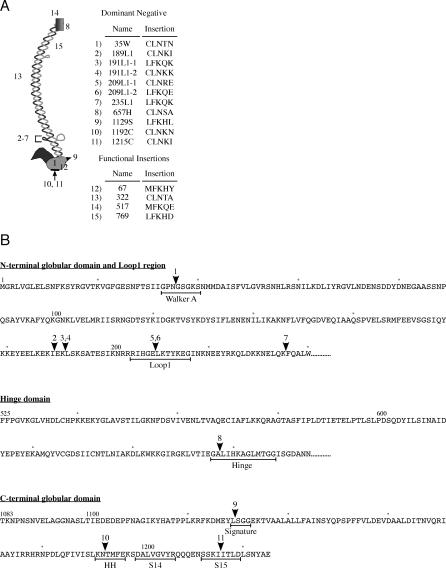
Insertion Mutations Disrupt Smc1 Function in Sister Chromatid Cohesion(A) A screen for dominant negative smc1 alleles identified 11 unique insertion mutations that cluster to previously characterized motifs in Smc1 (1, 8, 9) and uncharacterized Loop1 region (2–7, 10, 11) of Smc1. Clustering of insertions in these regions was a consequence of the dominant negative selection as evidenced by the different position of four functional insertion alleles (12–15) that can that rescue growth of an smc1–2 strain.(B) Position of the insertions and the relevant motifs in Smc1. Insertion names are based upon the position of the insertion in the primary amino acid sequence and the motif affectedC, C terminus; H, Hinge; L1, Loop1 region; S, Signature motif; W, Walker A.